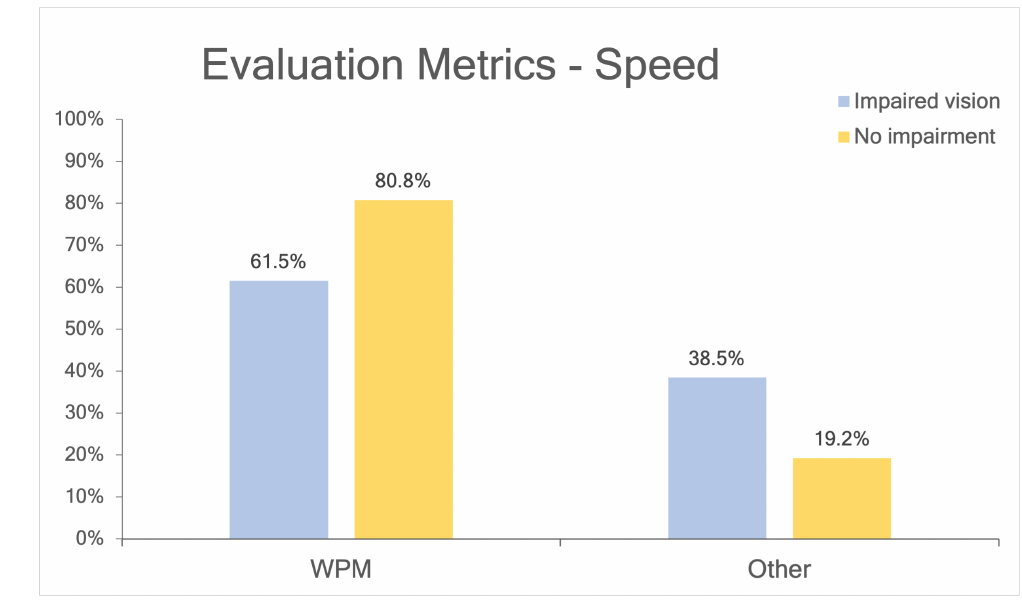
Figure 9. Proportion of studies using WPM or other text entry speed metrics.